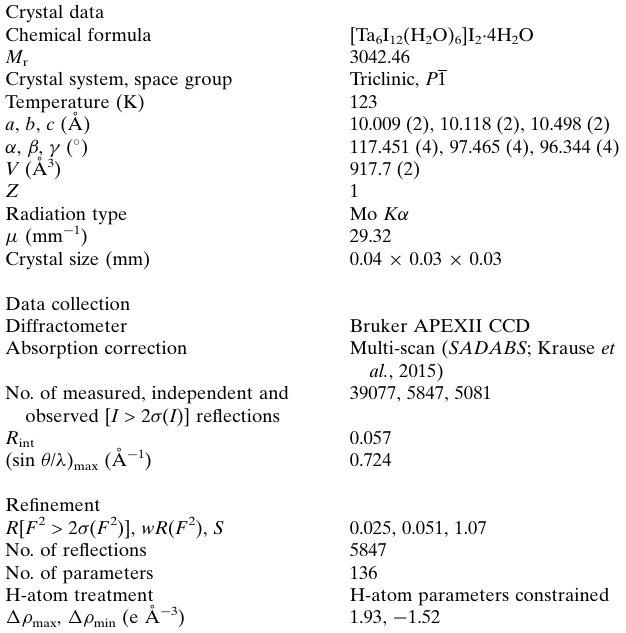
Table 2 Experimental details. Crystal data Chemical